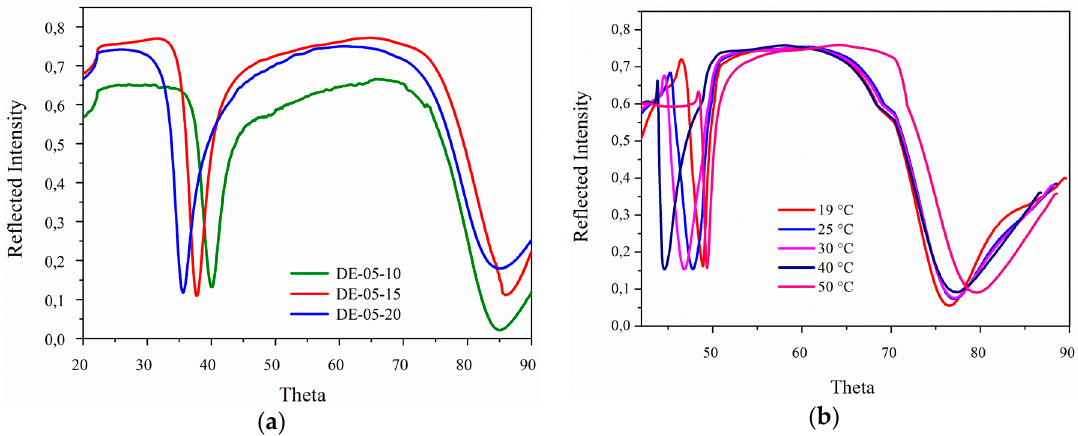
Figure 3. SPR scans of photo cross-linked polymer layers containing DEAMVA: ( a ) in the dry state for different DEAMVA contents; ( b ) in the swollen state for DE-05-15 at different temperatures.